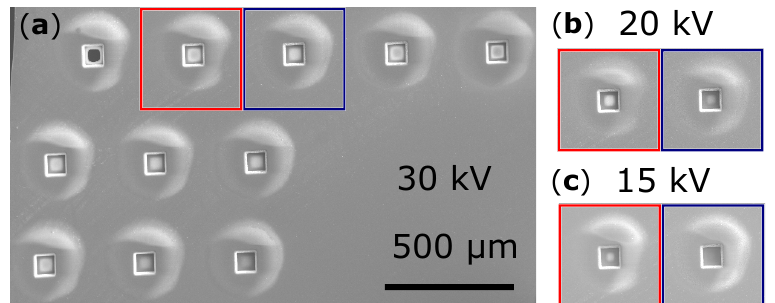
Figure 2. SEM images, acquired with the secondary electron detector, of windows with varying thicknesses in a 50 µ m-thick STO substrate at different electron acceleration voltages. ( a ) Overview of windows at 30 kV. The windows in the red and blue boxes are additionally shown for 20 kV ( b ) and 15 kV ( c